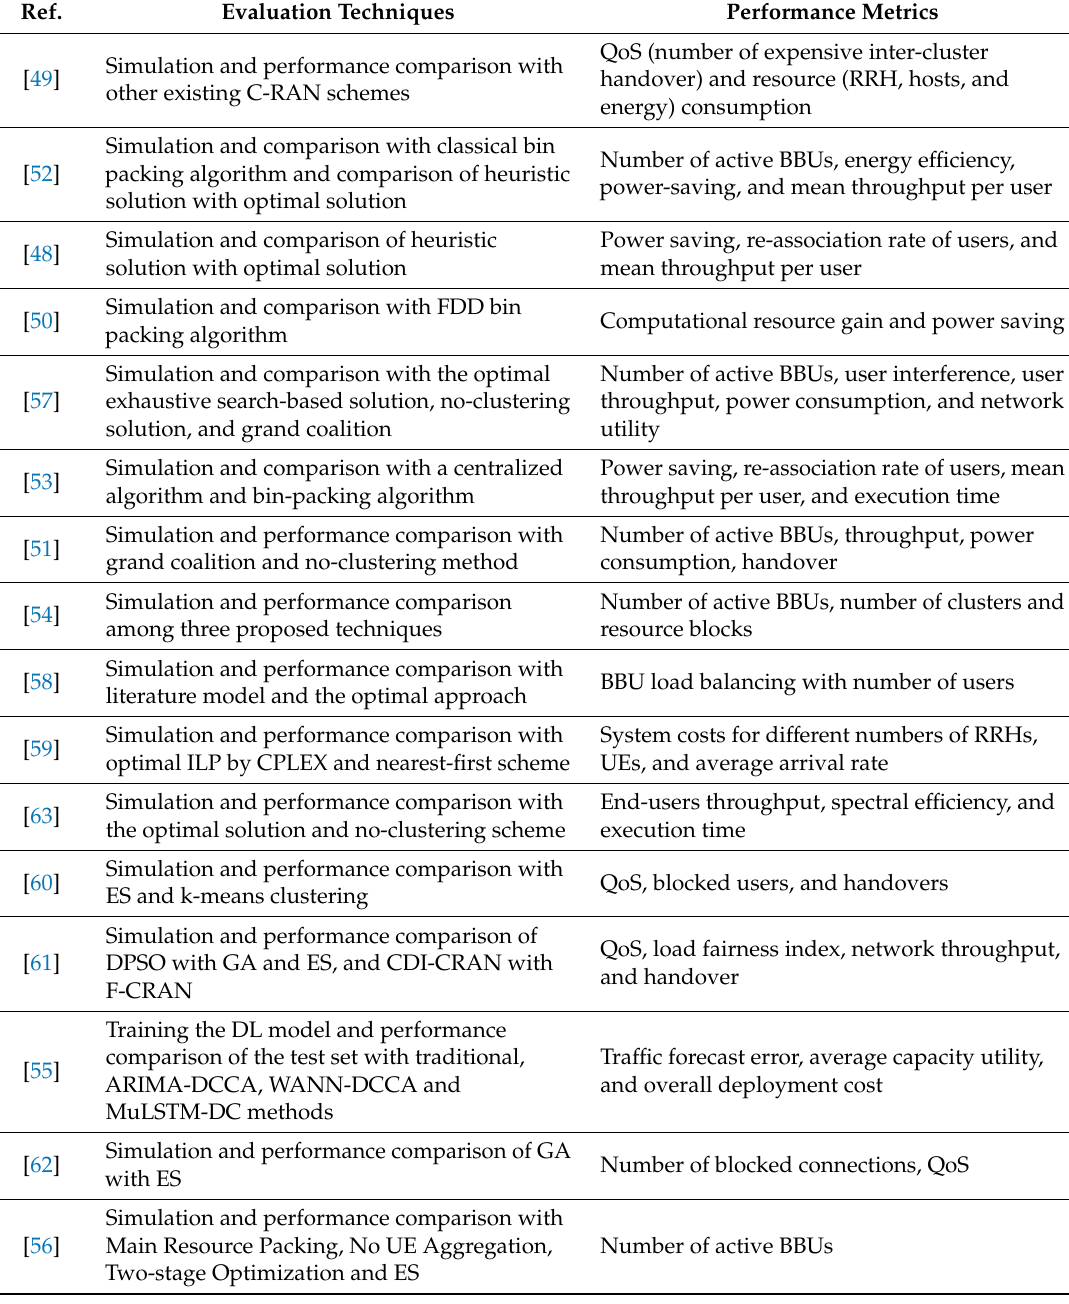
Table 4. Performance evaluation techniques and performance metrics used in RRH clustering technique.